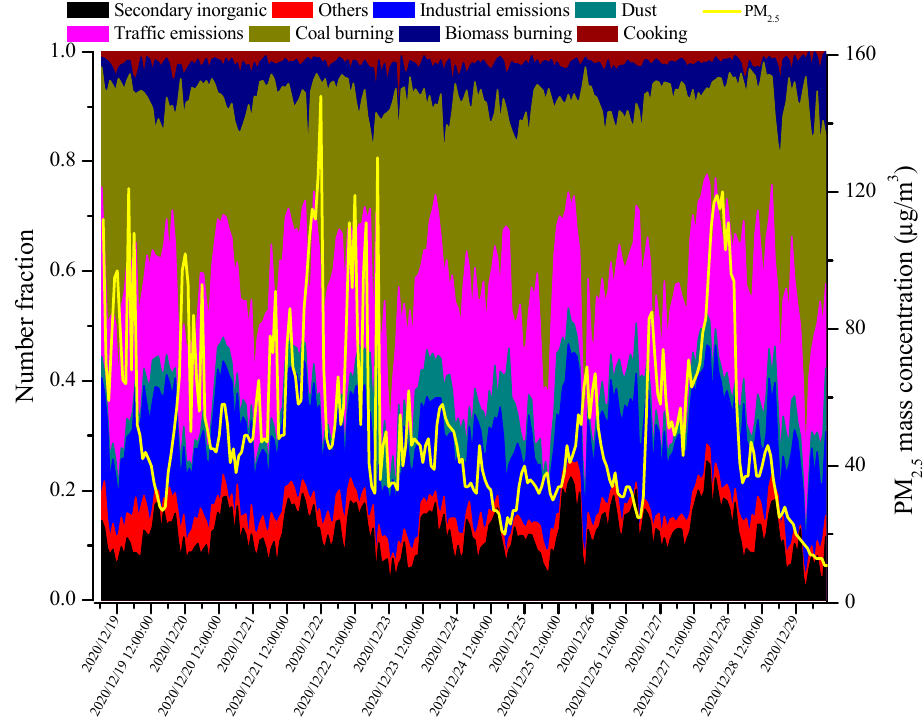
Figure 8. Temporal variation in the PM 2.5 mass concentration and number fraction of eight pollution source types.